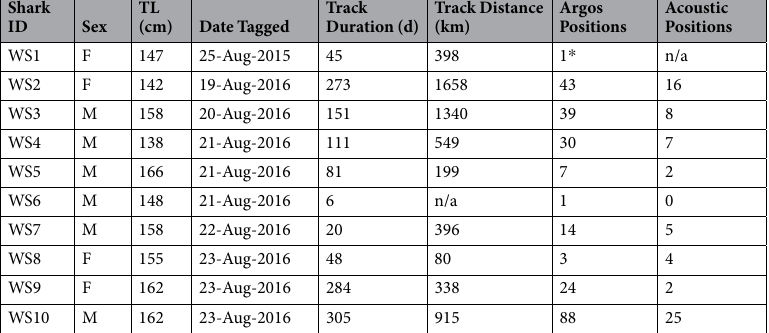
(mean = 17 ± 7 m) (Fig. 2a). The sea surface temperatures experienced by the sharks during this period were 16.2–25.0 °C (mean = 21.4 ± 1.6 °C). Seasonal migration and overwinter habitat. Post-summer (November onward) movement observa- tions were available from five white sharks (WS1, WS2, WS3, WS8, and WS9). These individuals departed the New York Bight during October and November, and moved southward over continental shelf waters (Fig. 3).